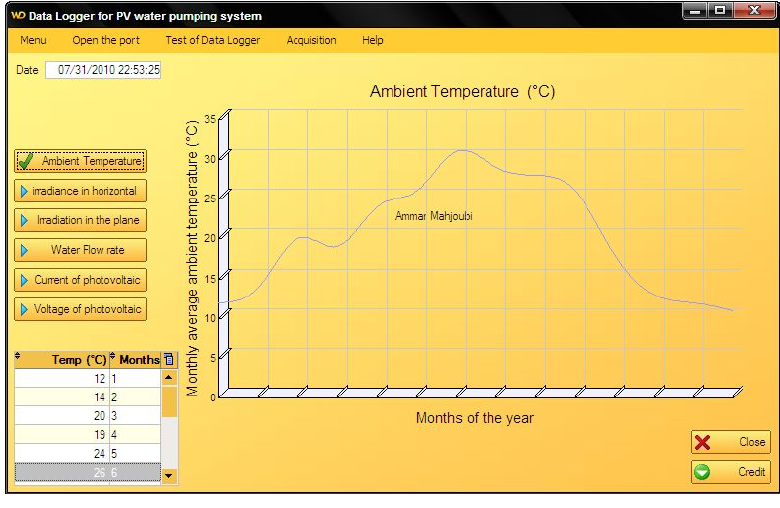
Figure 23. Measured monthly average ambient temperature of the year 2009 for